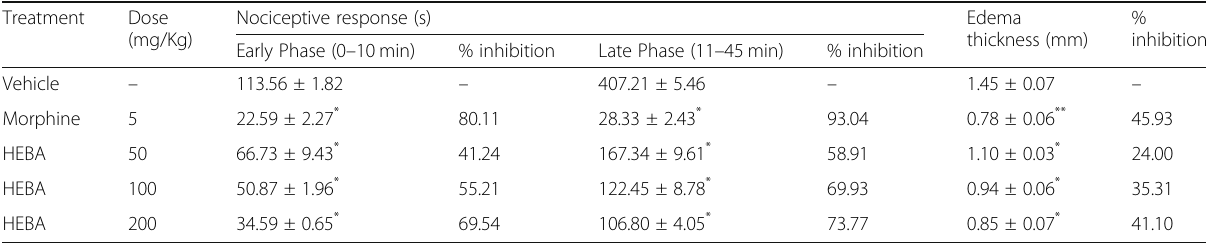
Table 1 Effect of hydro-alcoholic extract of A. lacucha (HEBA) in formalin-induced nociception test